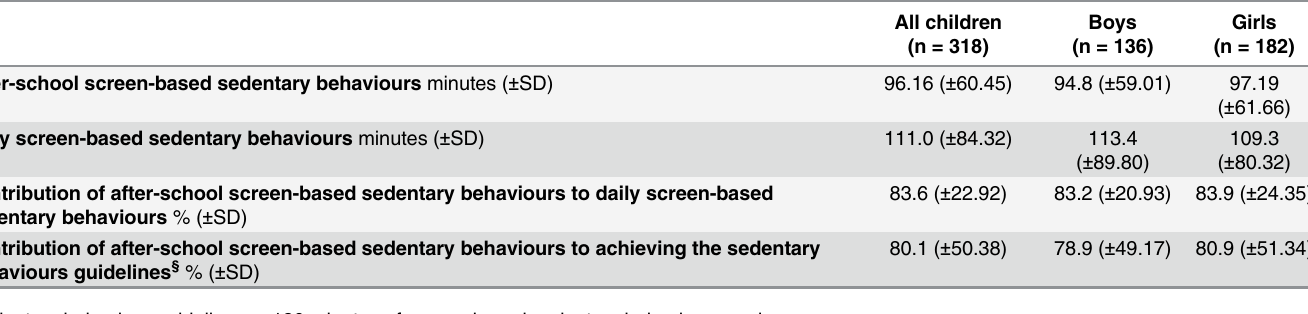
Table 2. Parental proxy-reported screen-based sedentary behaviours during the after-school period (mean minutes ± SD), and the contribution to daily screen-based sedentary behaviours ( ± SD) and achieving the sedentary behaviour (SB) guidelines ( ± SD).